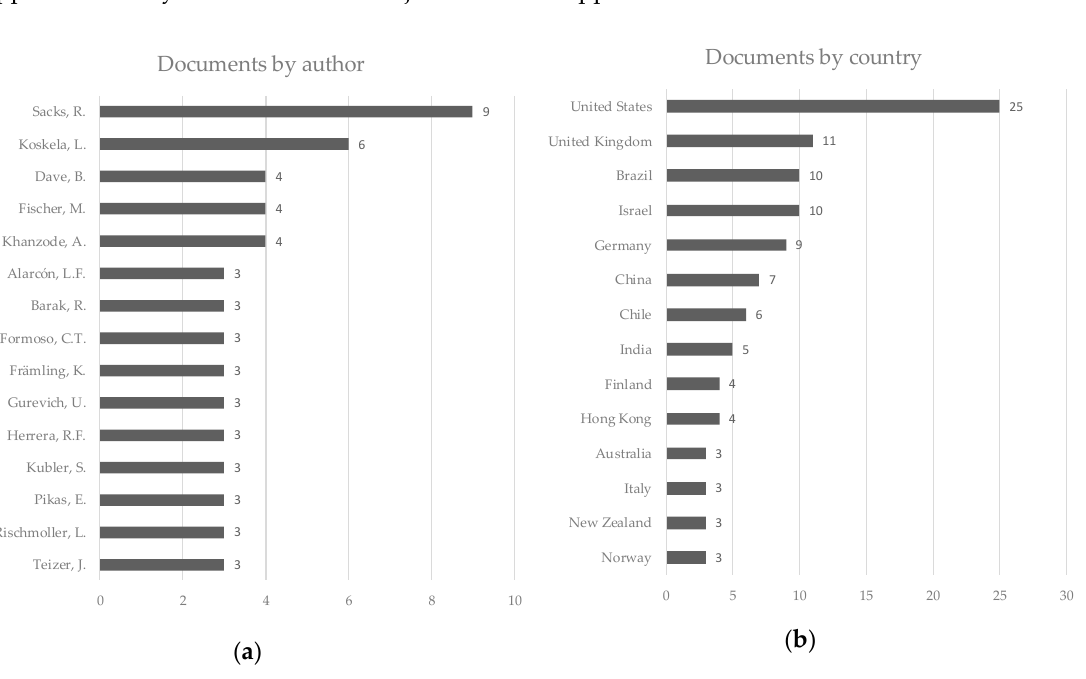
Figure 5. Documents by author ( a ); documents by country ( b ).